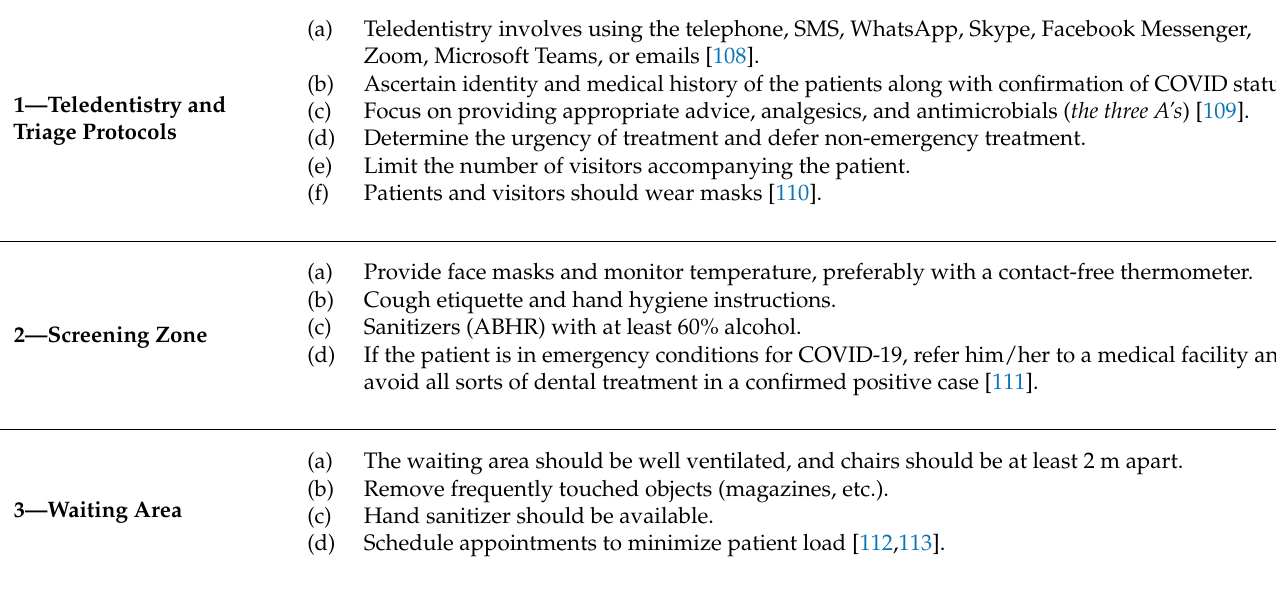
Table 6. Prevention and control of COVID-19 during dental